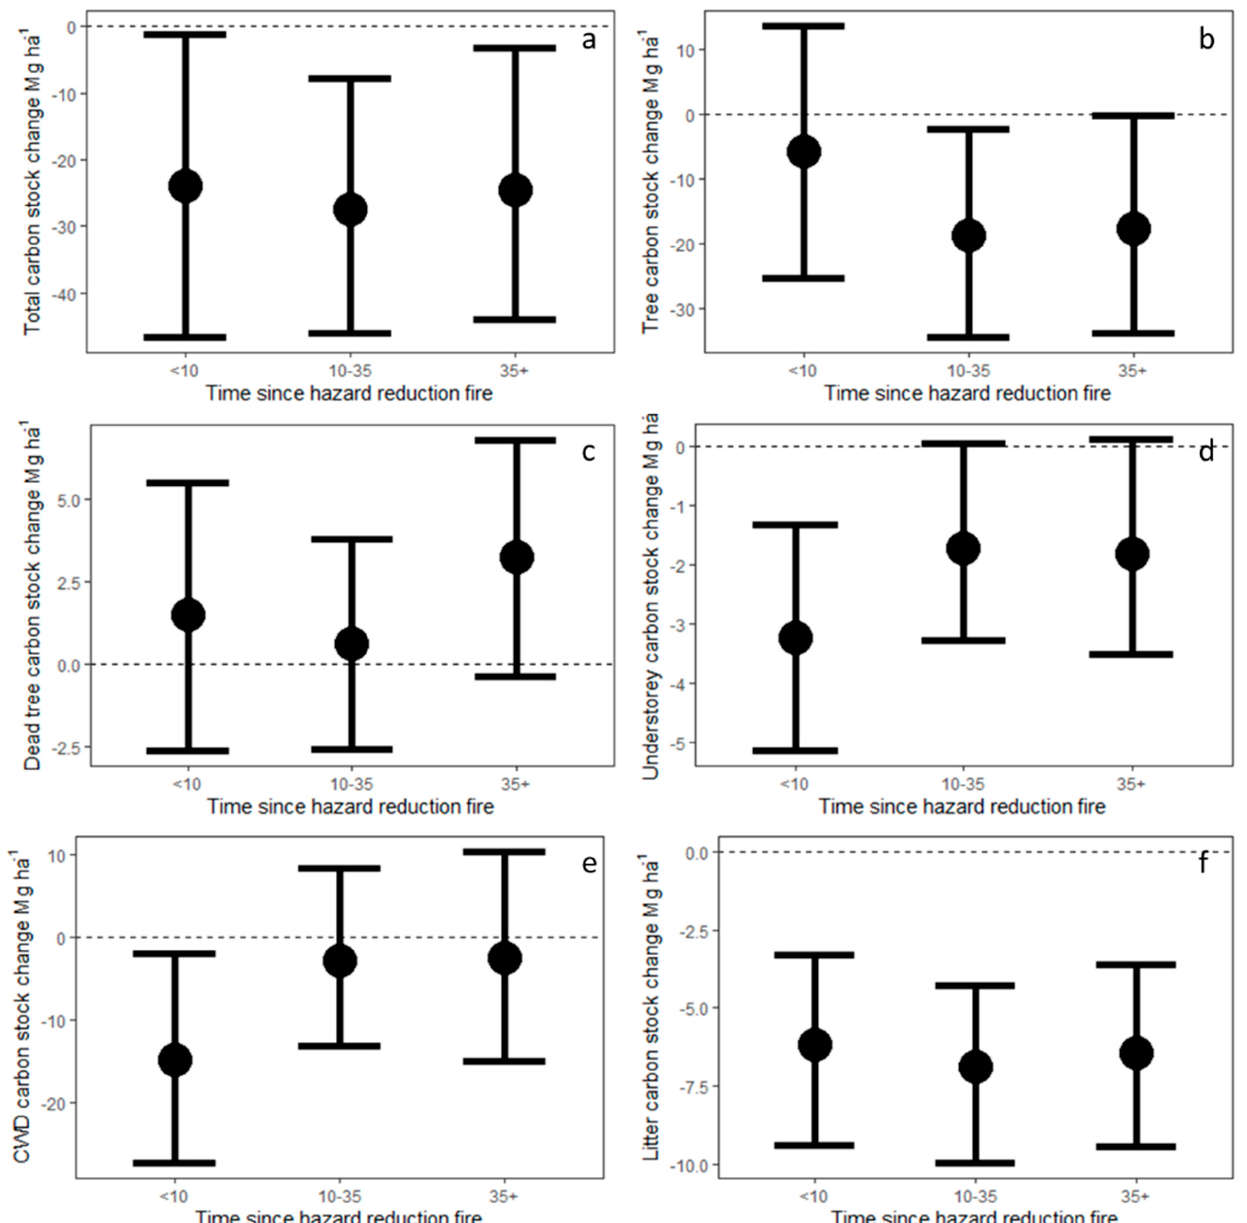
Figure 5. Change in total ( a ), live tree ( b ), dead tree ( c ), understorey ( d ), coarse woody debris ( e ) and litter ( f ) carbon stocks between the pre- and post-fire carbon surveys in response to time since the last hazard reduction fire. Central point and bounds indicate the median and 90% posterior density intervals respectively. Predictions were made with time since logging and time since fire at 40 years, fire severity fixed at ‘high’, topographic position at ‘Slope’ and all other variables at their mean. CWD = coarse woody debris.